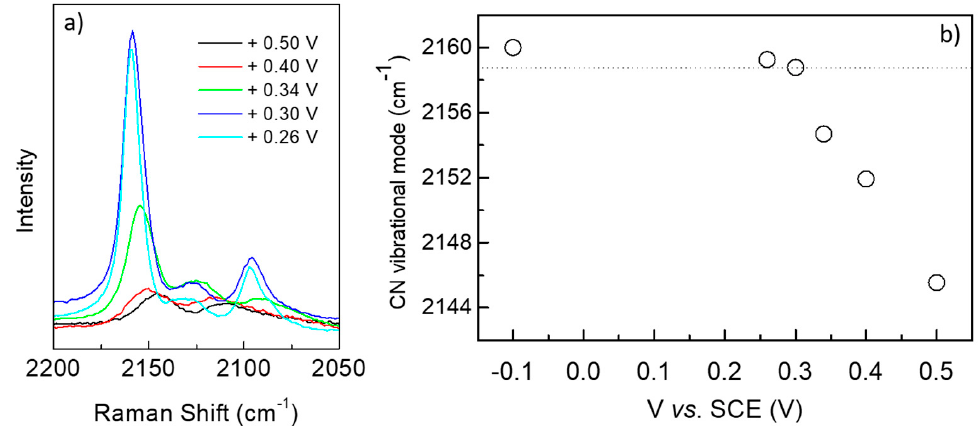
Figure 5. ( a ) Intensity and ( b ) peak position of the Raman peak for the existence of Fe 3+ species in the layers as a function of deposition potential. Electrodeposited charge for growing the layers was 50 mC.